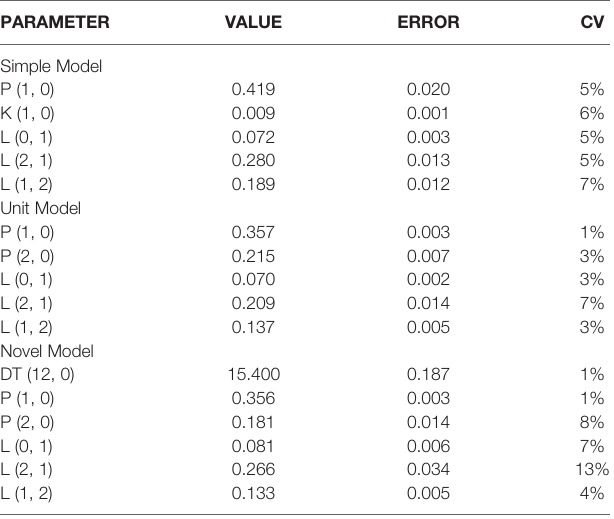
TABLE 2 | The estimates of the adjustable parameters (and their errors) for horse 5 using the SU, and N models (top to bottom). PARAMETER